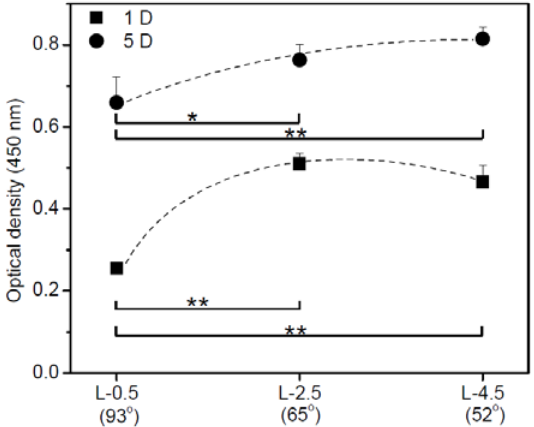
Figure 3. Human adipose-derived stem cell (hADSC) viability measured with a cell counting kit assay. hADSCs grown on each gradient surface (at 0.5 [L-0.5], 2.5 [L-2.5], and 4.5 [L-4.5] cm) were measured on days 1 and 5. Statistical analysis was performed using 1-way analysis of variance with Bonferroni’s multiple comparison ( * p < 0.01; ** p <